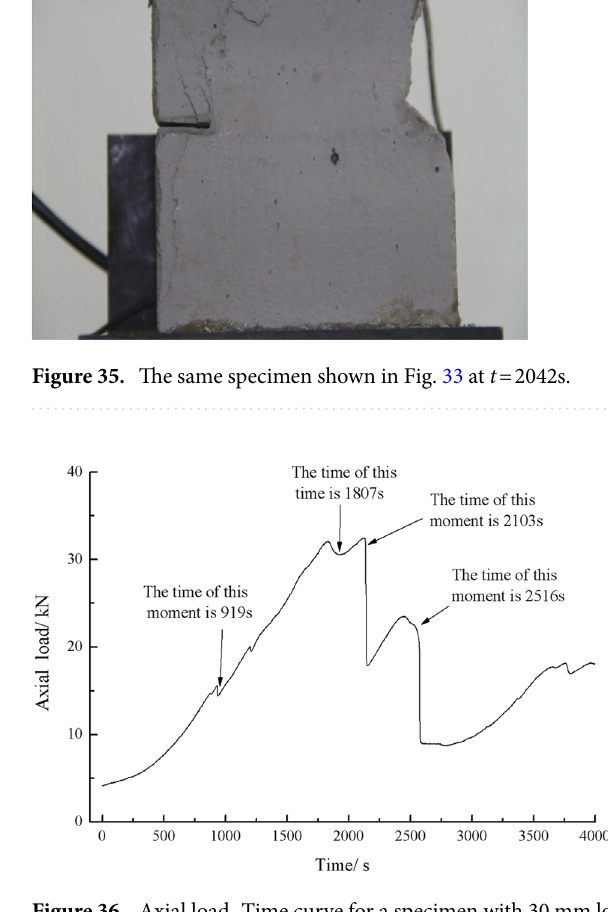
Figure 36. Axial load–Time curve for a specimen with 30 mm long cracks. Photographs of this specimen taken at the times marked on the curve are shown as Figs. 37, 38, 39 and 40.